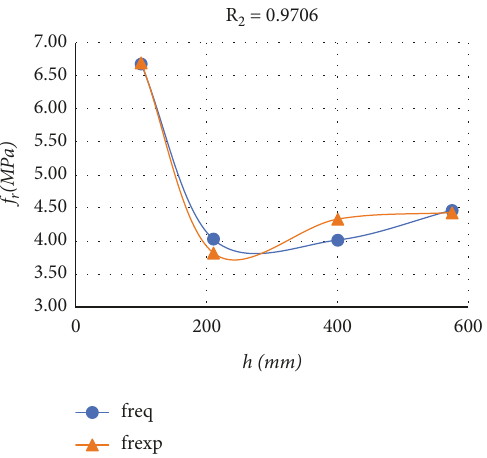
Figure 15: Comparison between modulus of rupture obtained by experiments and the derived equation in accordance with the beam depth with relative R 2